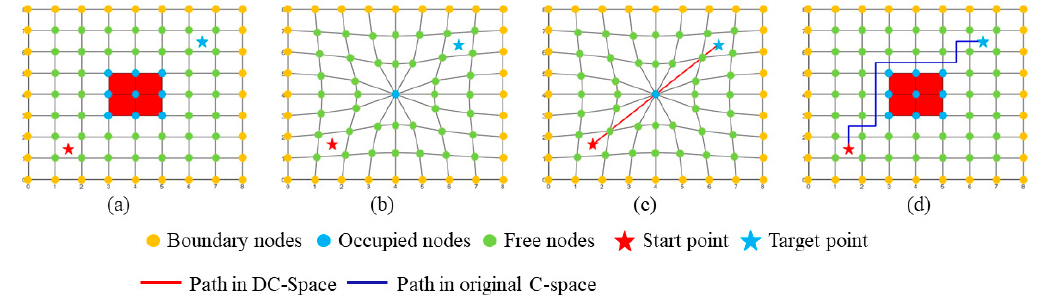
Figure 3. The process of path planning in DC-space. ( a ) C-space map. Grid nodes can be categorized into three types, boundary nodes (orange), free nodes (green), occupied nodes (blue). Occupied cells are colored in red, the start point (red star), and the target point (blue star) locate at the geometric center of the start cell and the target cell separately. ( b ) Obstacles collapse. The blue point is the collapse position for all the nodes in one obstacle. The free nodes are displaced accordingly. ( c ) Path generation in the DC-space. The start point and the target point are connected with one straight path (in red) directly. ( d ) Path restoration in the C-space. A feasible path (dark blue) that avoids the obstacle is built after projecting the straight path in DC-space back to the